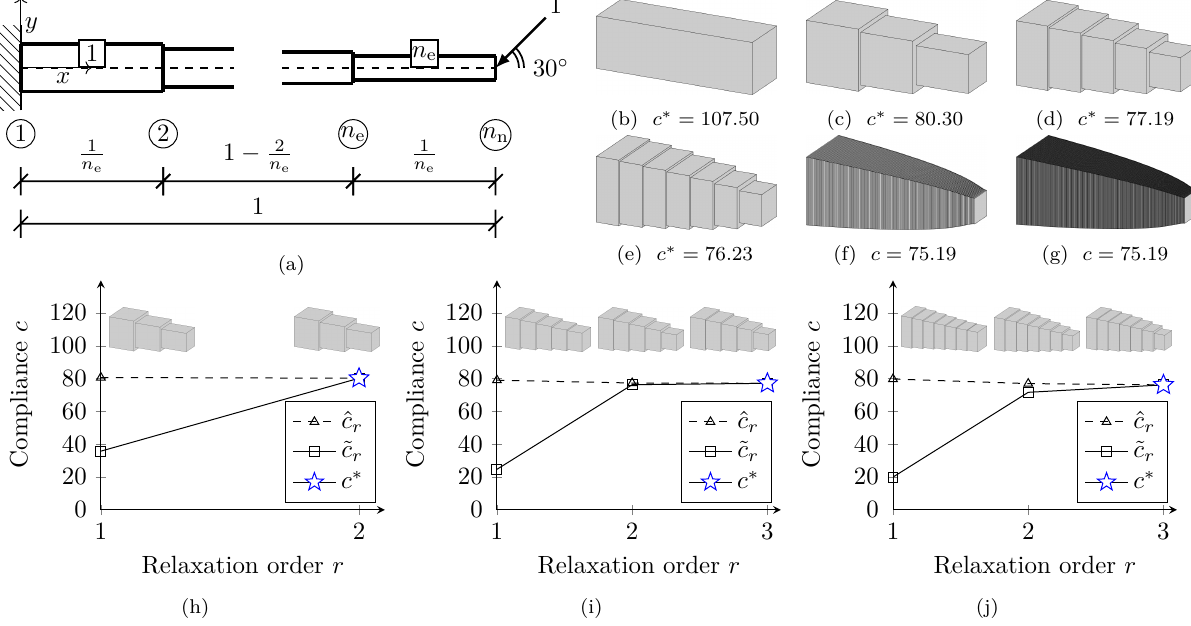
Figure 1. Cantilever beam design problem. (a) shows the design domain, (b)–(e) are the optimal topologies for 1, 3, 5, and 7 elements; (f) and (g) display optimized topologies computed by OC with discretization by 150 and 300 elements. Figures (h)–(j) show the convergance of PO for 3, 5, and 7